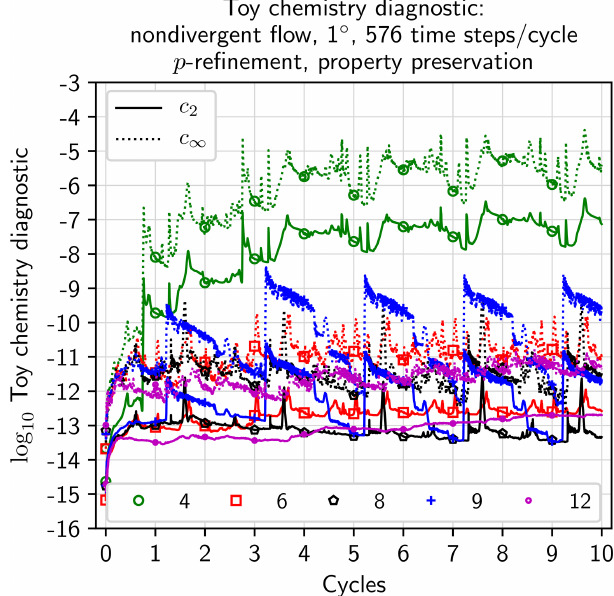
Figure 16. Toy chemistry diagnostic values as a function of time for 10 cycles of the non-divergent flow. Time is on the x axis and mea- sured in cycles. Diagnostic values c 2 (solid lines) and c ∞ (dashed lines) are on the y axis. Markers as listed in the bottom legend are placed at the start of each cycle to differentiate the